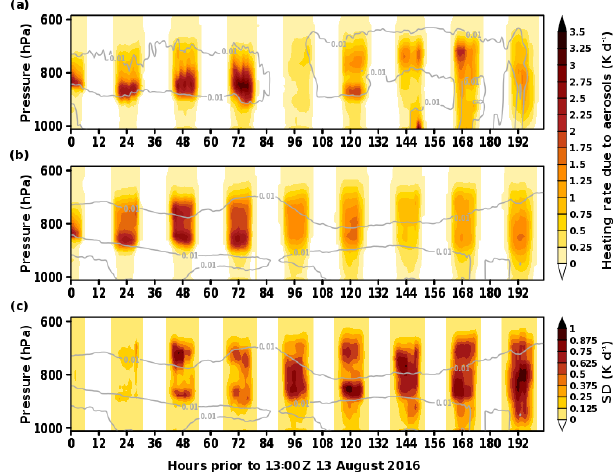
Figure 15. The SW heating rate profile due to aerosols (a) along the MERRA-2 trajectory, (b) the mean along the ensemble of back tra- jectories displayed in Fig. 10 using the GDAS ensemble members, and (c) the standard deviation originating at 2km over Ascension Island at 13:00Z on 13 August